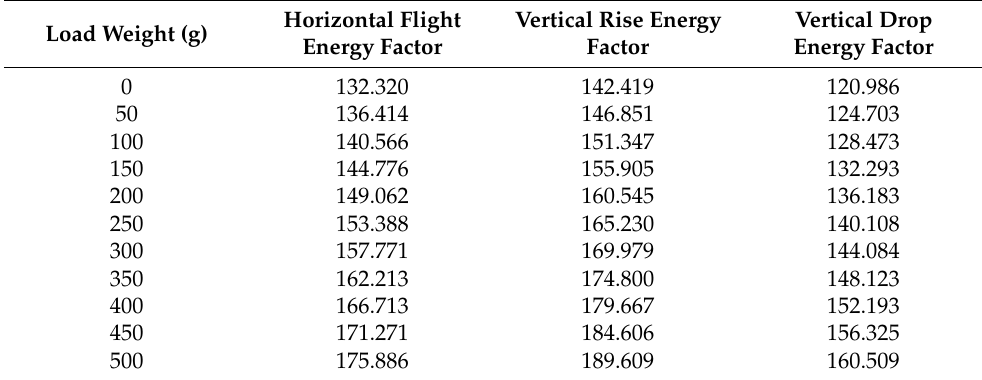
Table 1. Energy consumption coefficients under different load